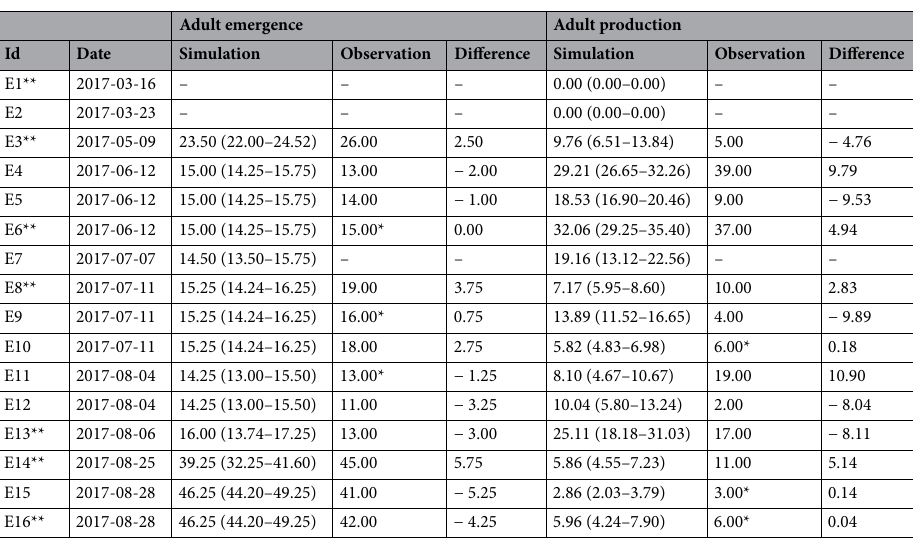
Table 1. Comparison of observed and simulated adult emergence time and the total number of adults produced. Simulation output is given in terms of the median and 90% range. *Observation within range **Used for model